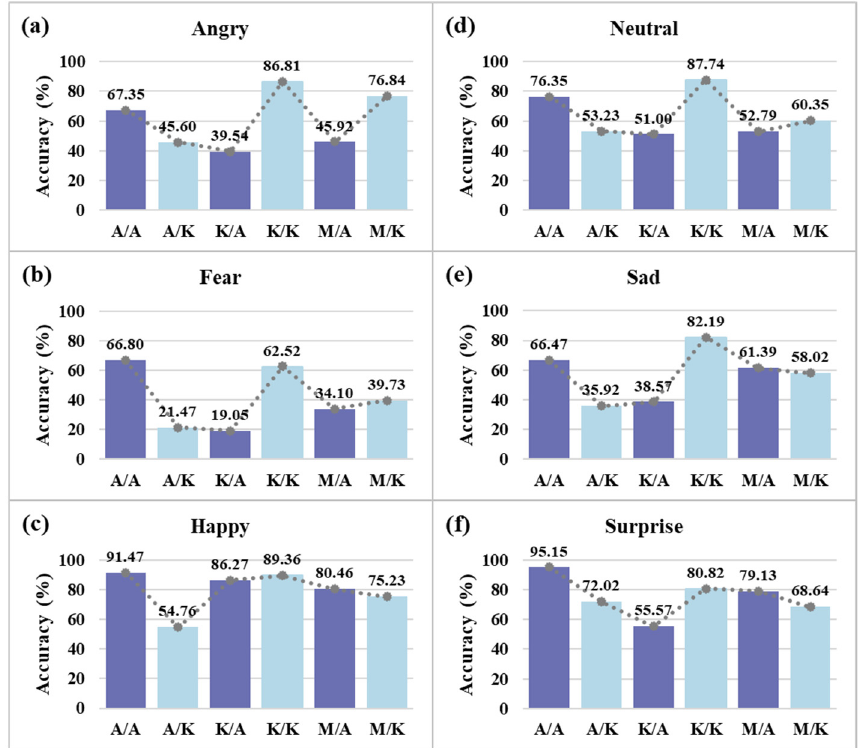
Figure 6. SE-ResNeXt50 (32 × 4 d)’s accuracy according to different emotions: ( a ) angry, ( b ) fear, ( c ) happy, ( d ) neutral, ( e ) sad, ( f ) surprise.